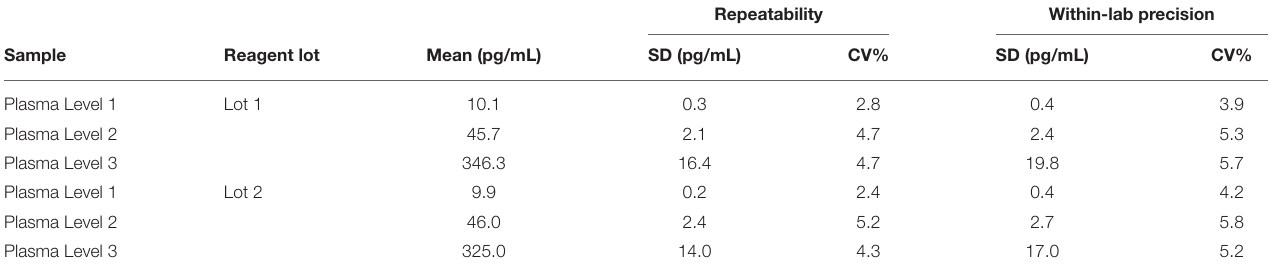
TABLE 5 | Precision with the LDT version of the NfL assay (K2 EDTA